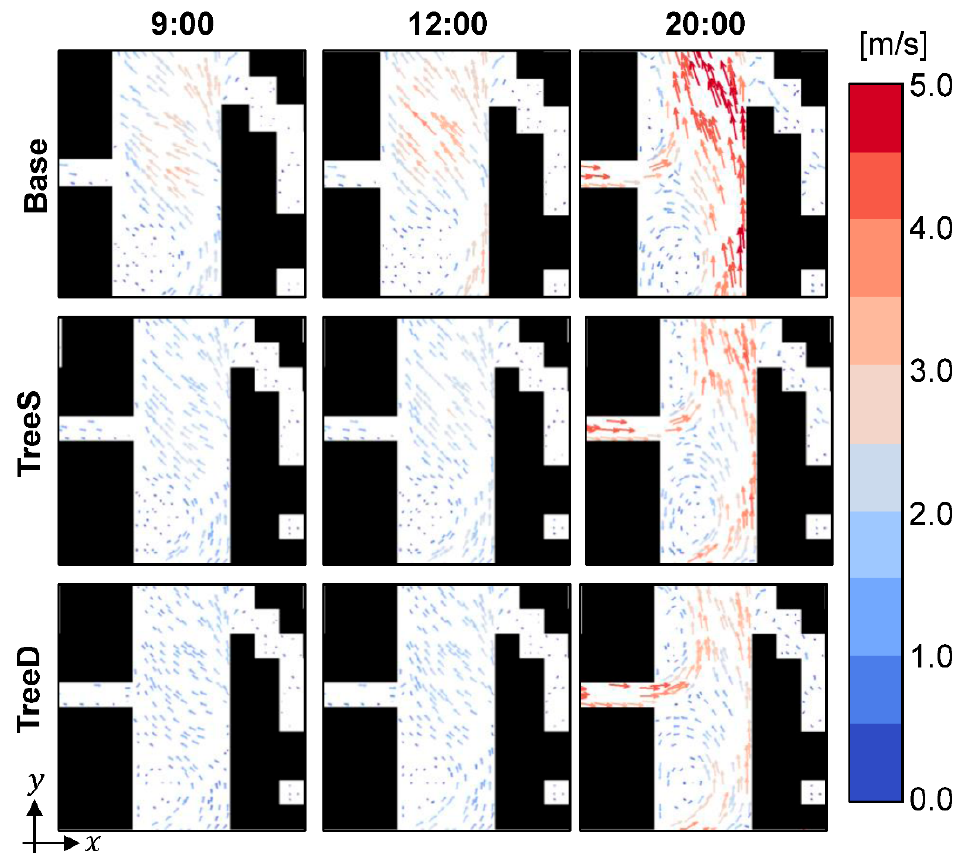
Figure 4. Flow fields at a 3.0 m height at 9:00, 12:00, and 20:00 for each case.